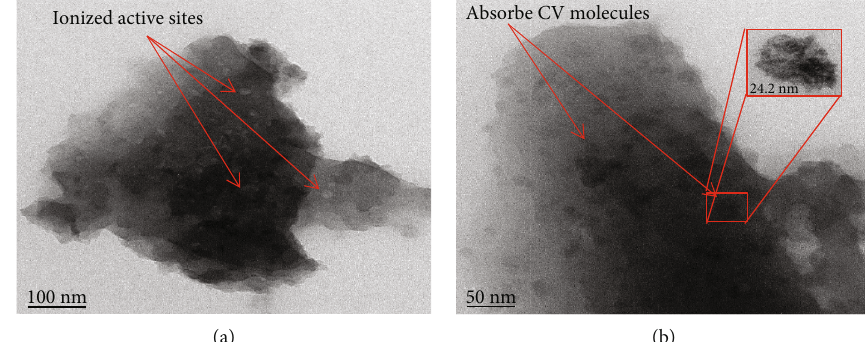
Figure 8: HR-TEM images for (a) unused ACMAS and (b) CV-loaded ACMAS.